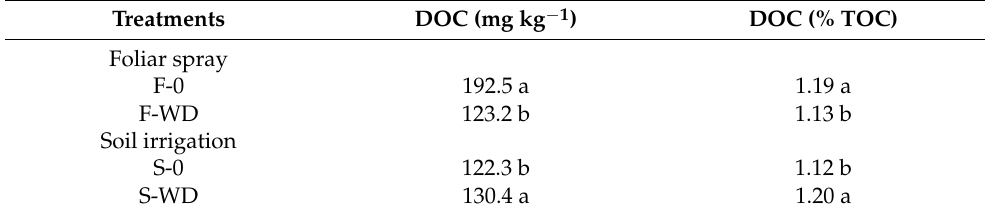
Table 1. Amount of soil dissolved organic carbon (DOC) and the DOC/TOC ratio as affected by the mean effects of foliar spray (F) and soil irrigation (S) with wood distillate (WD). Data are means of two treatments and three replicates ( n = 6). For each treatment and parameter, same letters indicate not significantly different means at p ≤ 0.05, Tukey test.